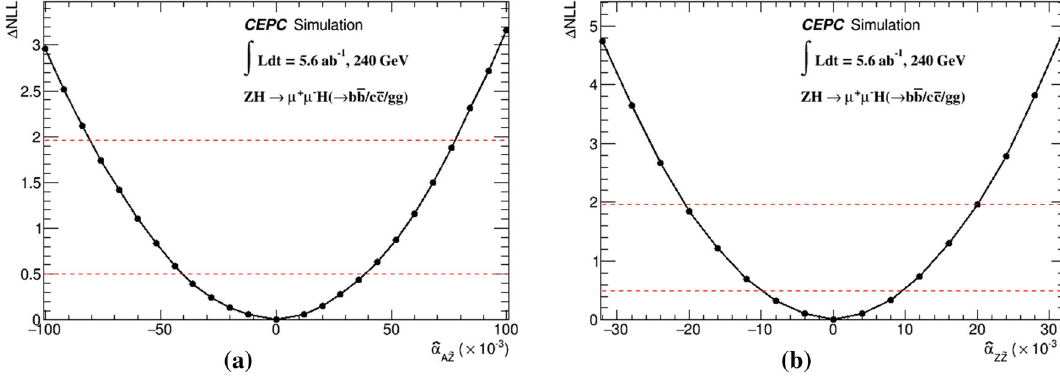
= with (cid:8) α Z ˜ Z A ˜ Z